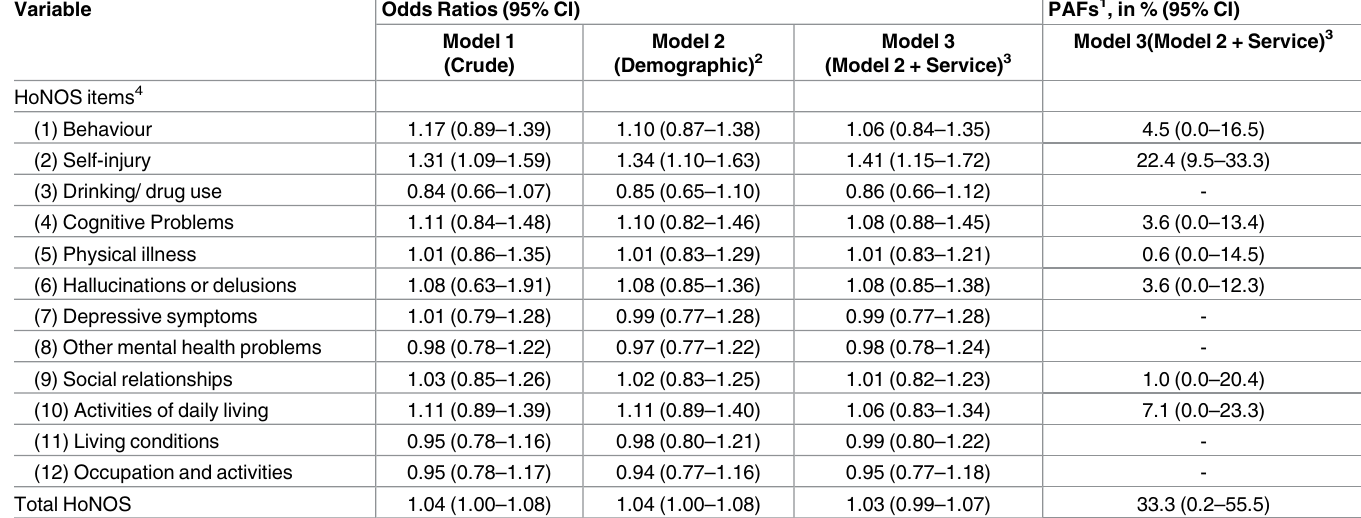
Table 3. Associations of individual HoNOS items and the Total HoNOS score (at baseline) with ‘regular’ vs ‘high’ mental health servicecosts (at one-year